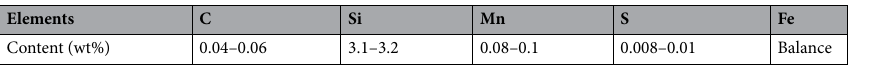
Table 1. Composition range of the cast ingots prepared in the present work.